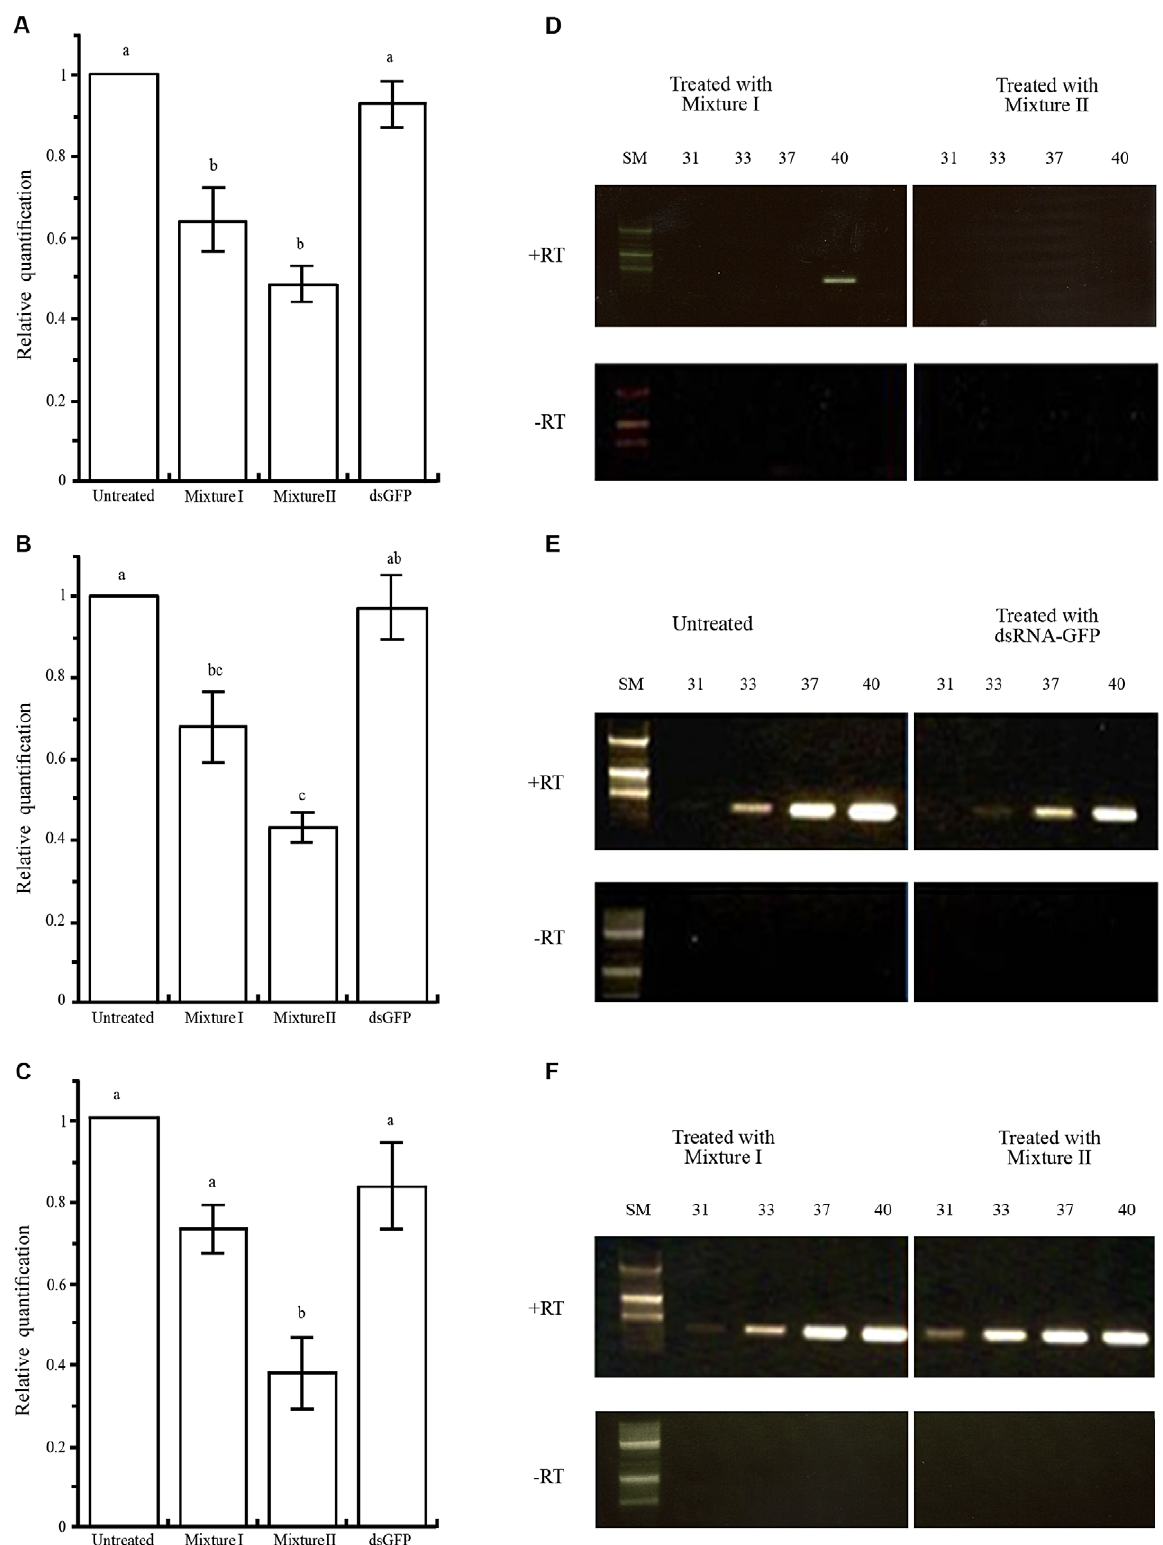
Figure 5. Silencing of Varroa gene expression following horizontal transfer of dsRNA from bee to Varroa . (A–C) Results (mean 6 SE) of real-time RT-PCR of Varroa genes 4, 14 and 9, respectively (Table S1). RNA from Varroa infesting untreated bees, which did not ingest dsRNA, or those that ingested the physiologically inert dsRNA-GFP served as controls. Note that treatment I is devoid of sequence 9. Different letters above columns indicate significant differences between treatments ( P , 0.05). Details of the RT-PCR assays and statistical analysis are described in the Materials and Methods. (D–E) Semi-quantitative RT-PCR for expression of the apoptosis inhibitor FAS gene (sequence 12, Table S1). RNA was extracted from Varroa